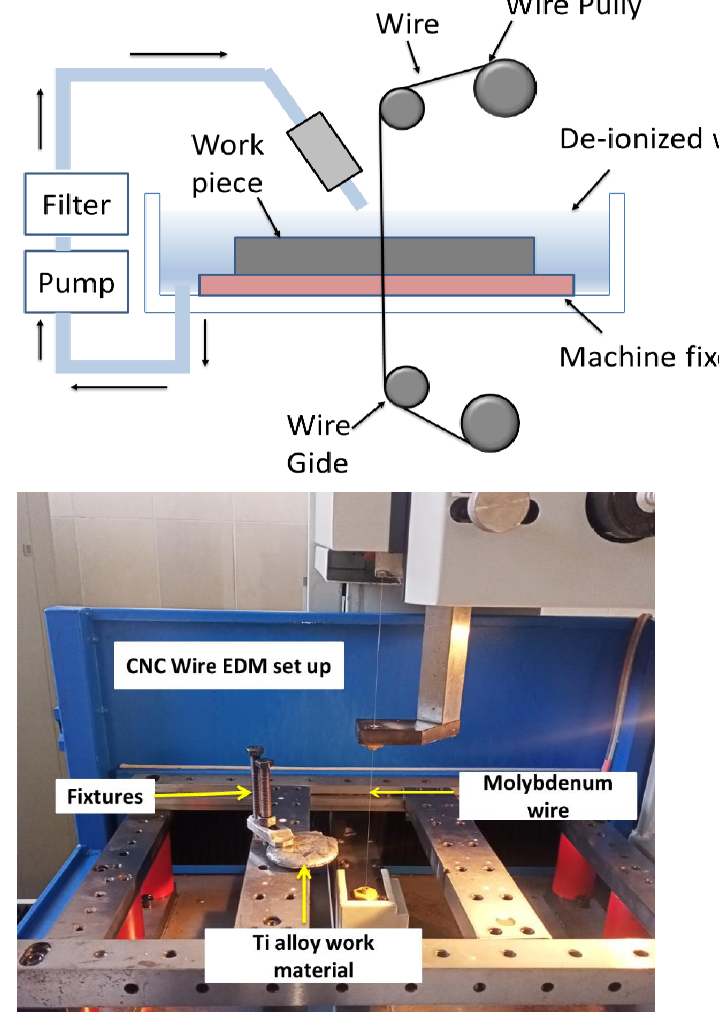
Figure 4. Wire electric discharge machining (WEDM) set up. Table 2. Process parameters and their levels.